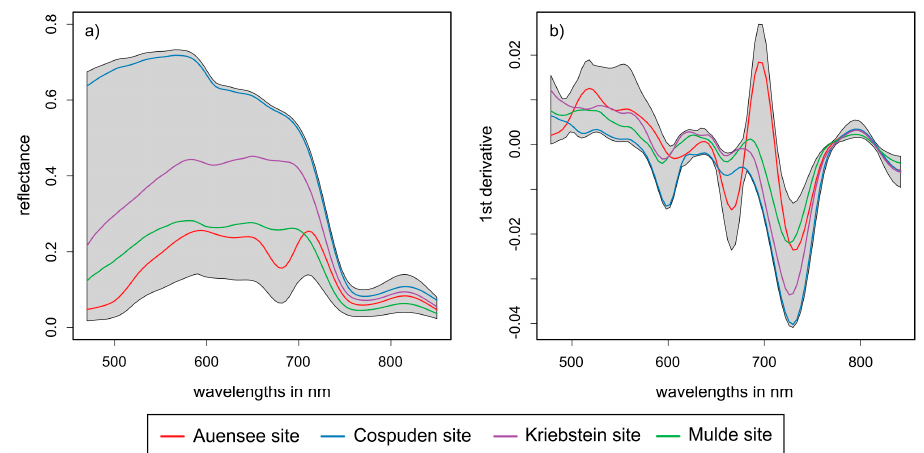
Figure 8. Mean visible and near-infrared (VNIR) reflectance spectra ( a ) and first derivative of mean VNIR reflectance spectra ( b ) of the investigated lake sites in the range 470–850 nm. The colored spectral curves represent the mean spectra of each lake. The shaded region displays the range between the minimum and maximum values at each wavelength for the entire data set.